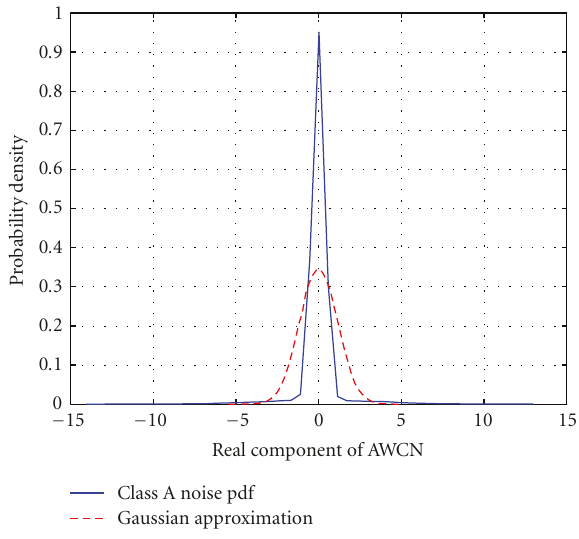
Figure 2: Probability density function of real component of AWCN ( A = 0 . 1, GIR = 0 . 1, σ 2 = 1 .